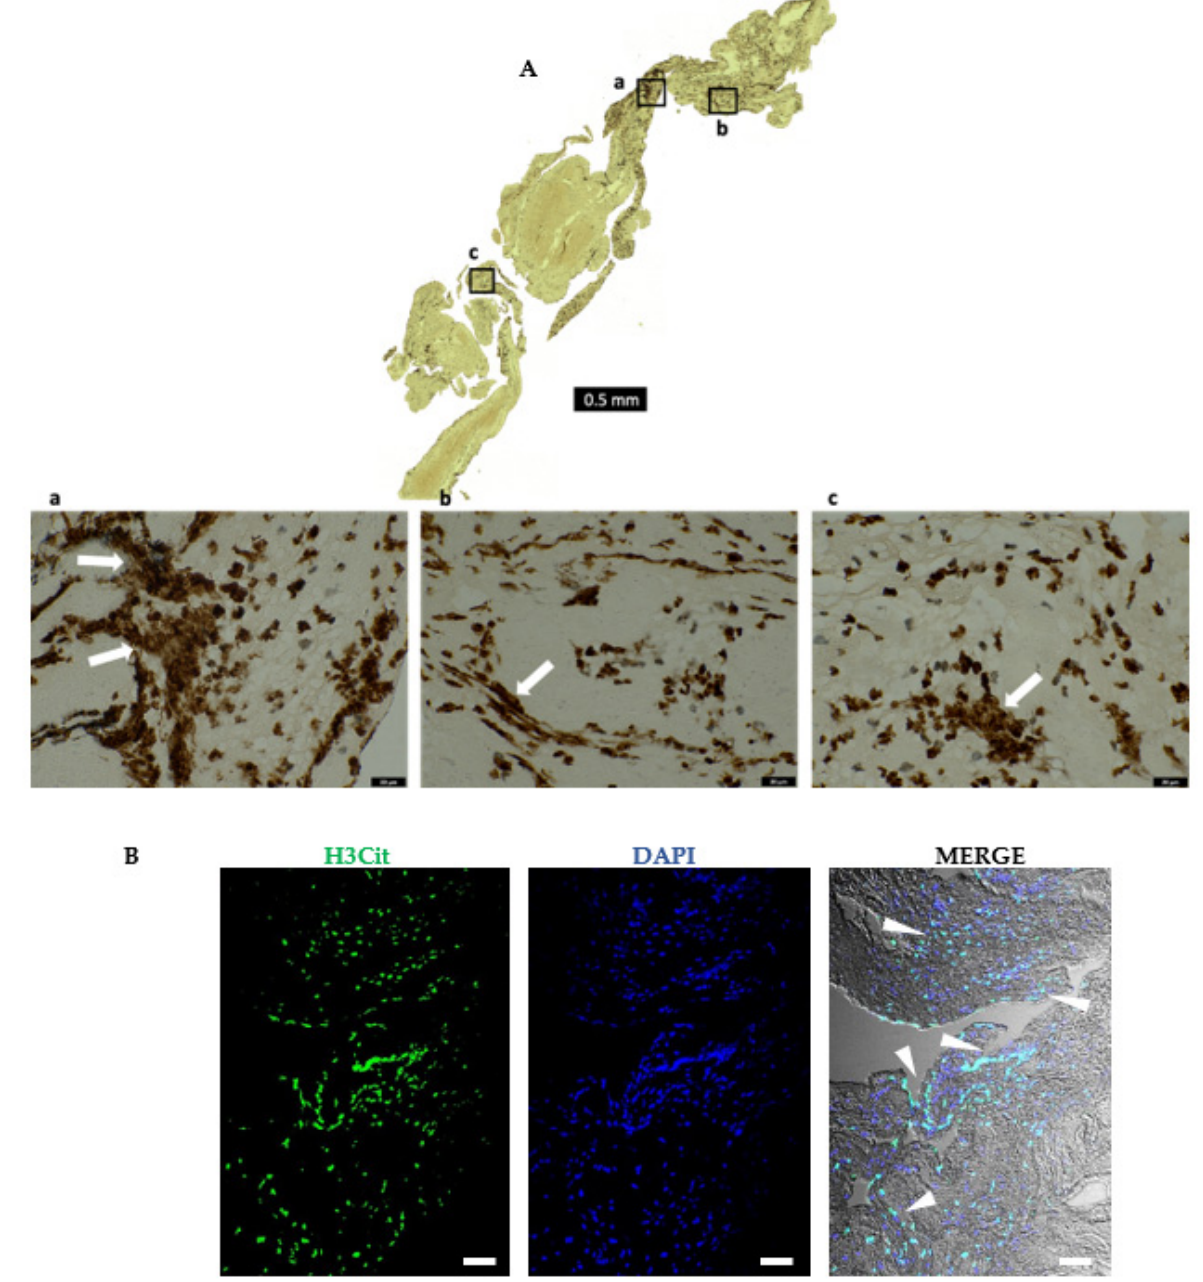
Figure 7. AIS patient thrombi show the constitutive presence of NETs. ( A ) Representative immunohistochemical staining of retrieved stroke thrombus using an antibody against citrullinated histone (H3Cit), a marker for NETs. Abundant NET formation that appears intracellular as well as diffused extracellularly (white arrows in ( a – c )), mainly in the platelet-rich areas and at the thrombi periphery can be seen. Scale bars: 500 μ m: upper panel, and 20 μ m: bottom panels. ( B ) Representative immunofluorescence image of retrieved stroke thrombus stained for DNA (DAPI, blue), and with antibody against citrullinated histone (H3Cit, green). The diffused nuclear material mainly in the periphery (blue in DAPI) colocalizes with H3Cit (green), as shown by arrowheads in the merged image. Scale bars are 100 μ m.